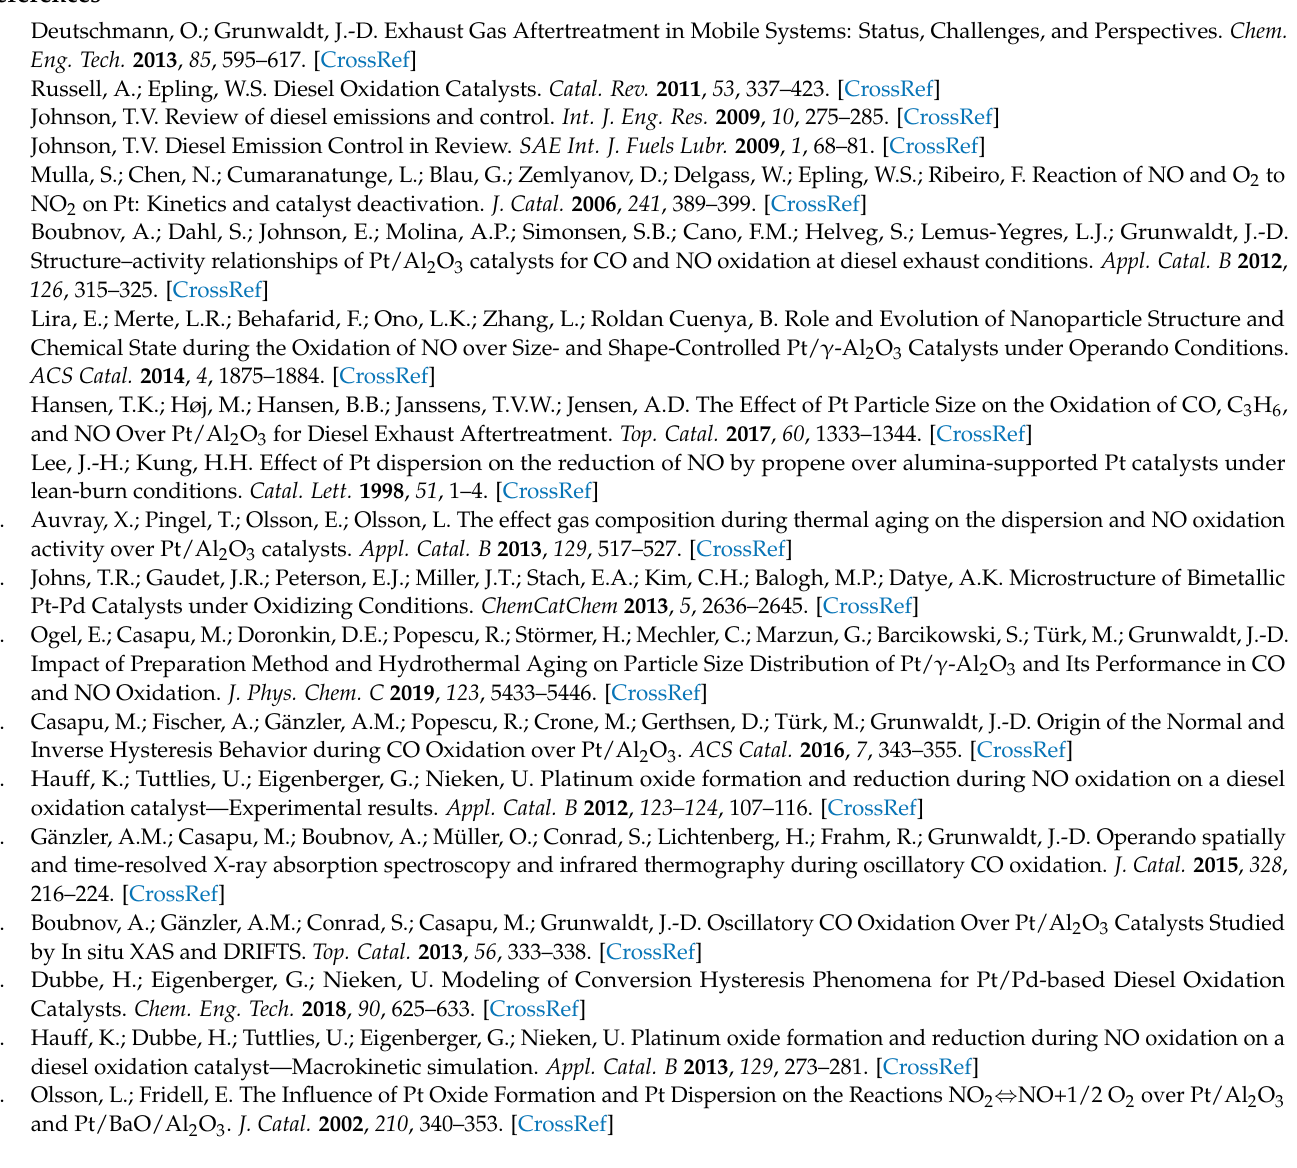
Figure A6. Turnover frequency (TOF) for CO oxidation at 120 °C of Pt/Al 2 O 3 , Pd/Al 2 O 3 and Pt-Pd/Al 2 O 3 during a light-off test (after reductive pretreatment) in 800 ppm CO, 7% CO 2 , 5% O 2 , 5% H 2 O, and bal. N 2 at a GHSV of 80 000 h − 1 .